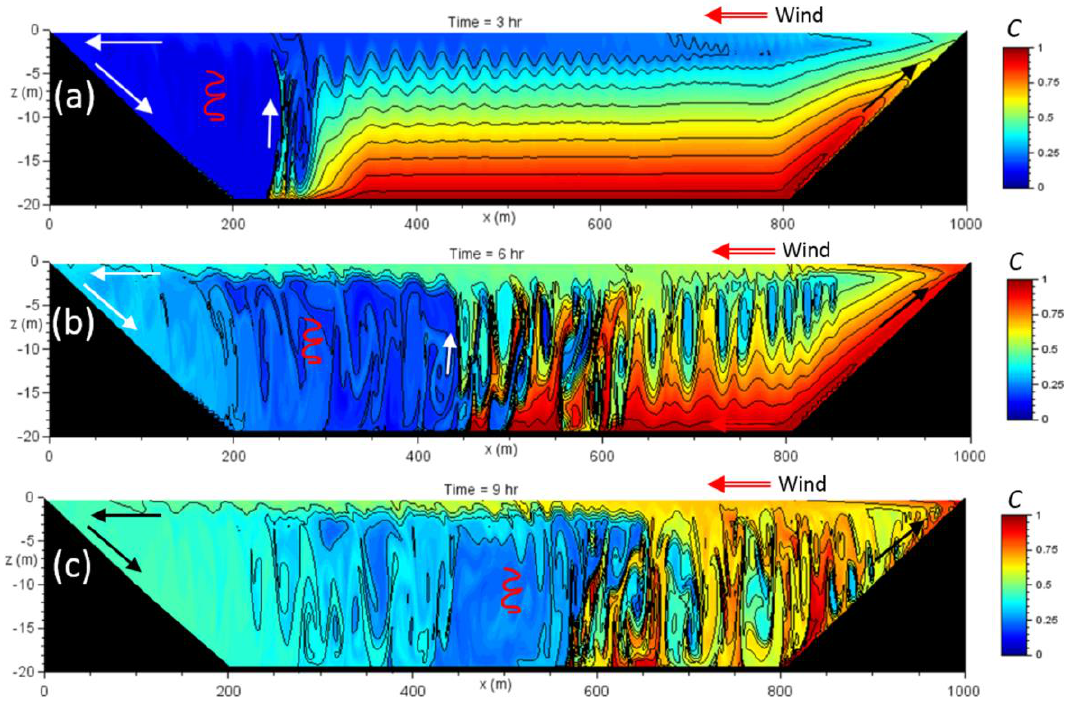
Figure 4. Scenario A ( N = 0) with τ x = − 0.1 Pa. Shown is the evolution of the concentration field C after ( a ) 3 h, ( b ) 6 h and ( c ) 9 h of simulation. Arrows indicate flows. Wiggly curves indicate vertical stirring. See GIF Animation S1 for a simulation of this experiment.